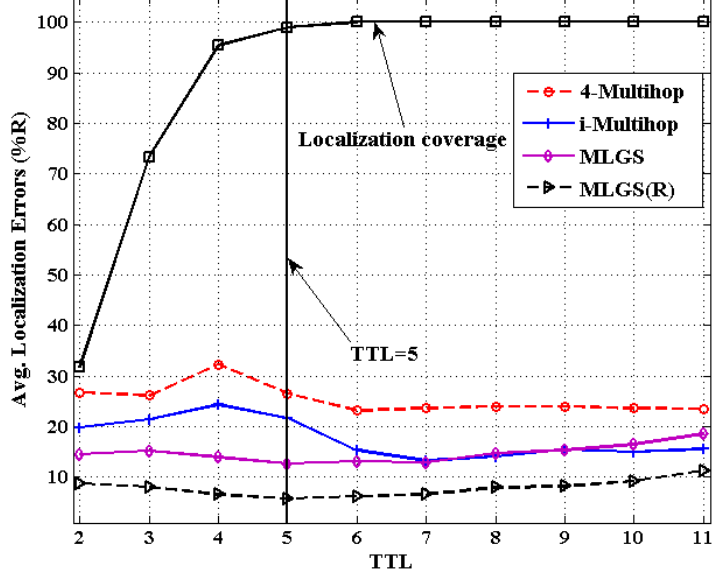
Figure 13. Average localization error versus TTL (anisotropic